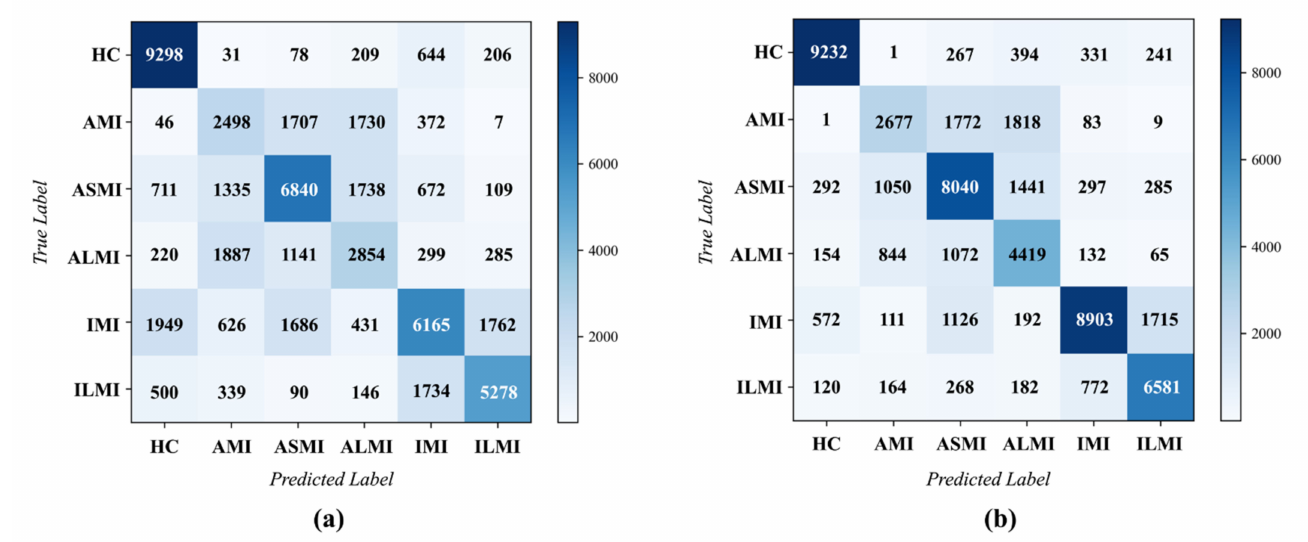
Figure 11. The confusion matrix of MI localization on the PTB database. ( a ) Based on a single